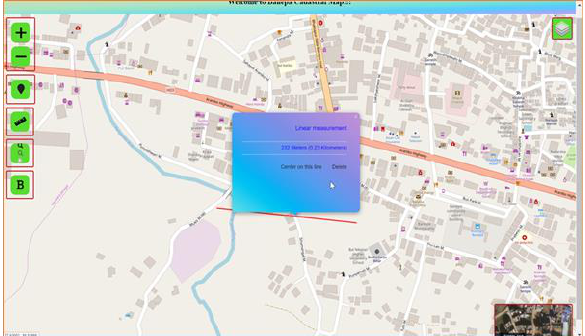
Figure 6. Distance between two drawn points on the map